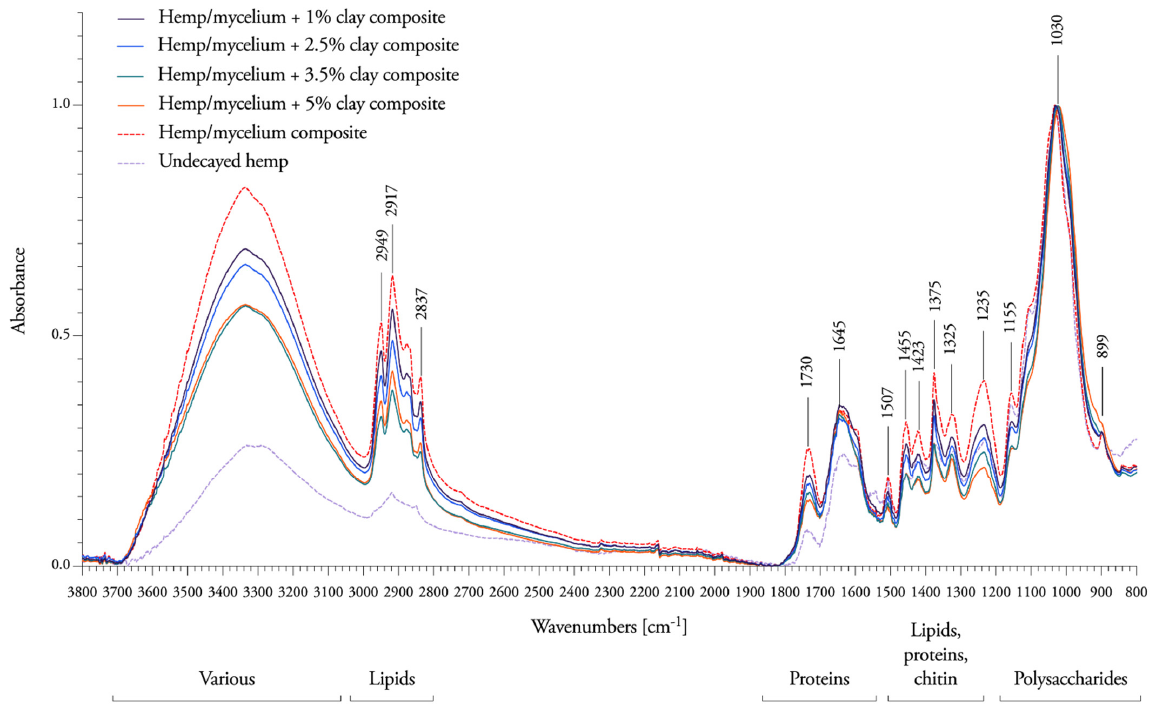
Figure 7. Mean FTIR spectra of 1–2.5–3.5–5% nanoclay–mycelium composites, mycelium composite without nanoclay (dotted line) on a hemp substrate after growth of 7 days, and undecayed hemp fibers (dashed line).